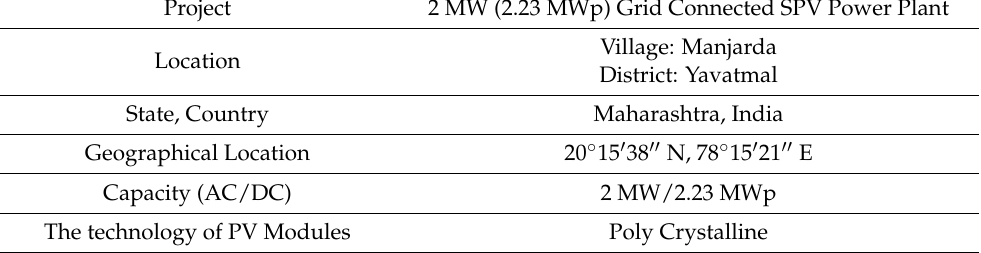
Table 1. Site Credentials.